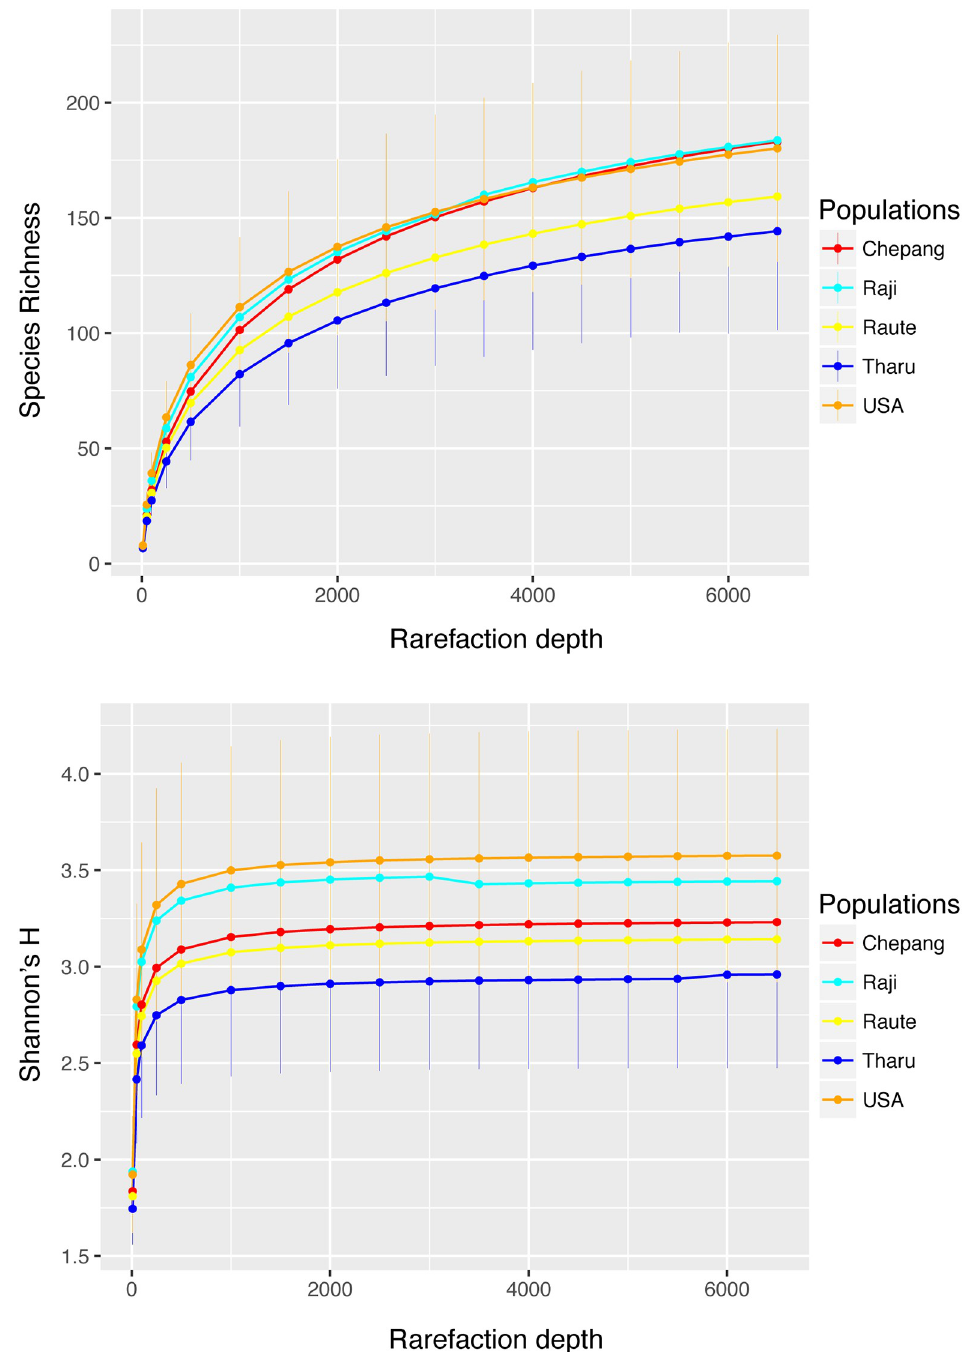
Fig 4. Alpha diversity across lifestyles. Rarefaction curves showing two commonly used measures of alpha diversity— species richness (top) and Shannon’s H (bottom) calculated by subsampling 10–6,500 reads per sample. No significant differences in species richness was detected between the five study populations at a lower depth of 3,000 reads per sample, which included all 64 samples, or at 6,500 reads per sample, which included 61 samples. Shannon’s H was significantly lower in the Tharu relative to the Americans at both rarefaction depths. No differences in any of these two alpha diversity metrics were observed between the Chepang, Raji, Raute, and the Americans. Population labels are colored to indicate the range of different lifestyles (red, foragers; yellow and cyan, former foragers; blue, farmers; orange, industrialists). The data underlying this figure can be found in S1 Data.